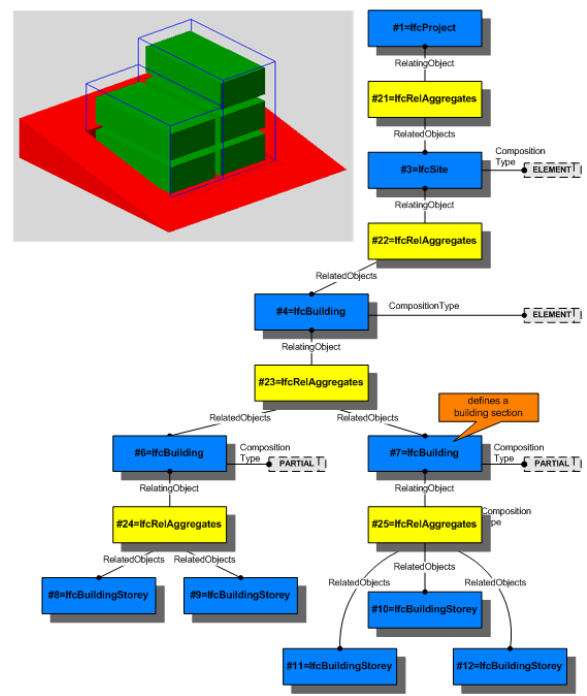
Figure 4. A hierarchy of building features in